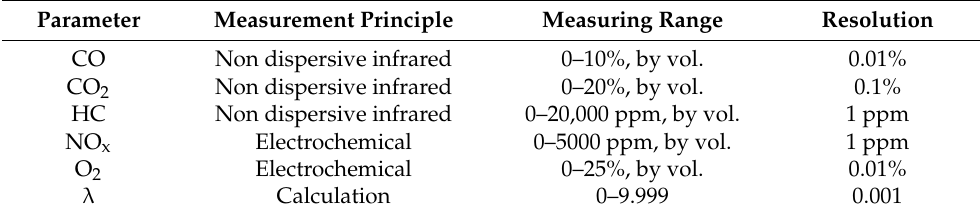
Table 3. AVL DICOM 4000 measurement range and